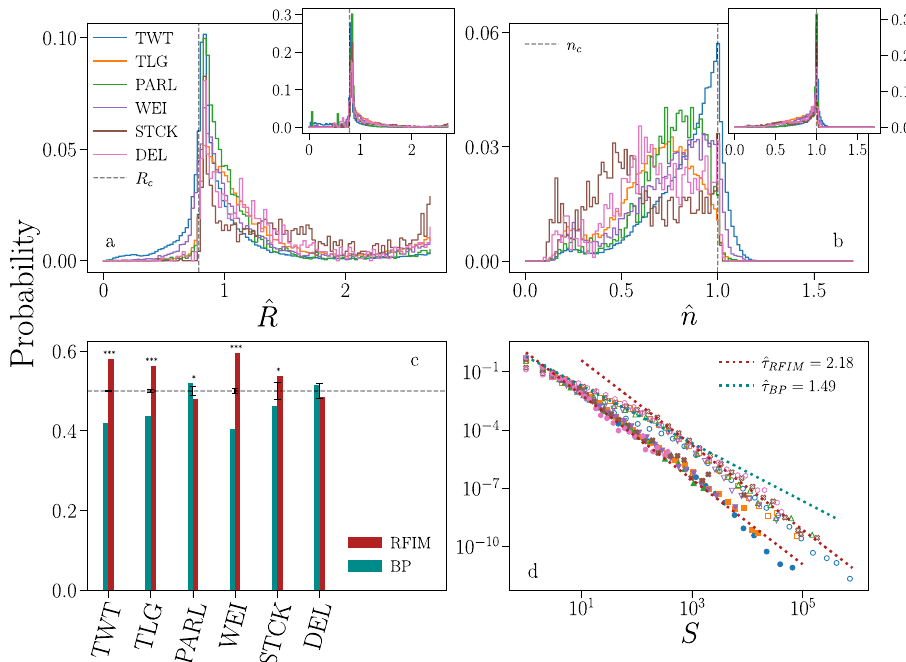
Fig. 3 Criticality and complexity of information propagation in online social media. a We fi t each individual time series against the Random Field Ising Model (RFIM) to determine the best estimator of the disorder parameter ^ R . We then compute the distribution of ^ R for all time series of a given data set. Acronyms of the data sets are de fi ned as in Fig. 1. We fi t only avalanches whose size is at least equal to S min = 10. The dashed vertical gray line denotes R c , i.e., the critical value of the RFIM parameter. The inset shows the same data as in main panel, but each time series contributes to the histogram with a weight equal to its total number of events. b Same analysis as in a , but obtained by fi tting individual time series against the branching process (BP) to determine the best estimator of the branching ratio ^ n . c Probability that the log-likelihood ratio test favors the RFIM over the BP (teal), or vice versa the BP over the RFIM (red). Only time series that are suf fi ciently well fi tted by both models are considered in the analysis, see Fig. 4b. Error bars represent σ / N , ffiffiffiffiffiffiffiffiffiffiffiffiffiffi p where N is the sample size and σ ¼ 0 : 25 N is the standard deviation of a binomial distribution with probability of success equal to 1/2. Asterisks are used to denote signi fi cant deviations from the unbiased binomial model, i.e., three asterisks indicate p < 0.001, and one asterisk stands for p < 0.1. d We use the classi fi cation of panel c to divide time series in two distinct classes. We then consider only time series whose best estimators are suf fi ciently close to the critical value of the model representing their class, i.e., j ^ R (cid:2) R c j = R c (cid:4) 0 : 05 or j ^ n (cid:2) n c j = n c (cid:4) 0 : 05, to compute the distribution of avalanche size for each class. Full symbols are used for the RFIM class, empty markers are used to display the distributions of the BP class. The dotted lines correspond to the best fi t of the exponent τ to the RFIM (red) and to the BP